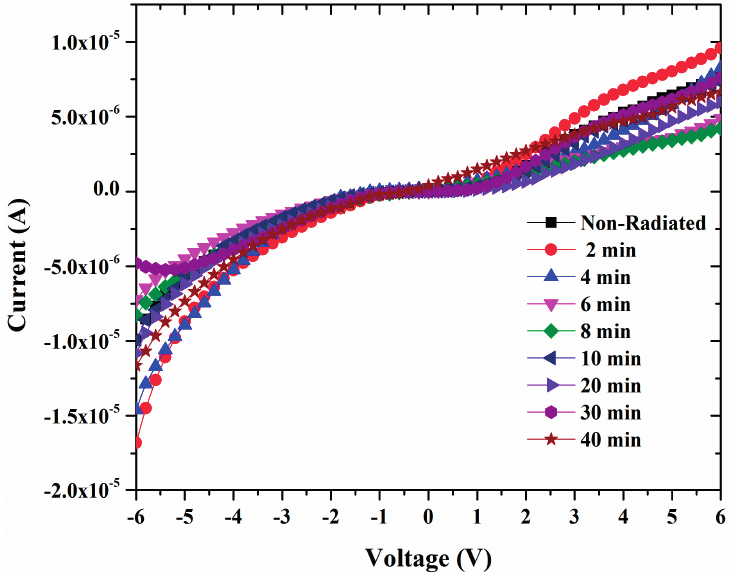
Figure 2. Graphs demonstrates the relationship between current and voltage for forward and reverse